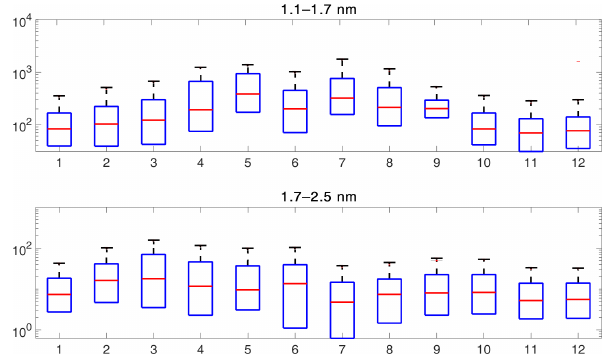
Figure 5. The annual variation of the particle concentration in the two PSM size bins. The red line shows the median concentration for each month and the blue box contains 50% (25th to 75th percentile) of all data points. The whiskers mark the location of the 95th and 5th percentile data